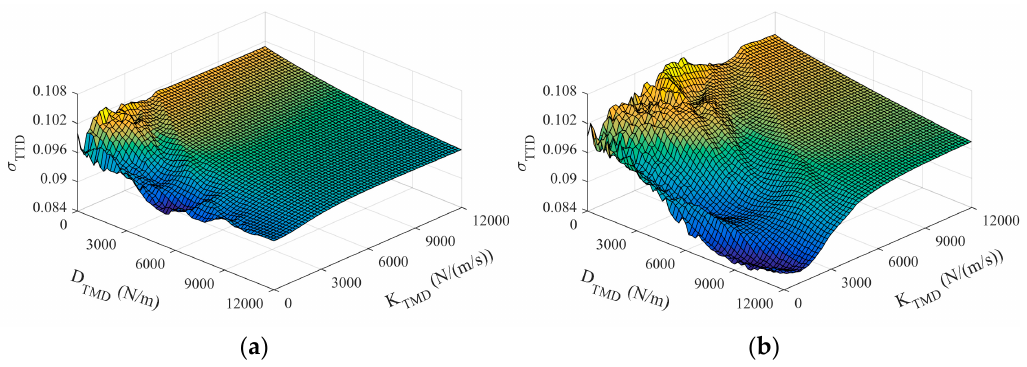
σ for different TMD mass ( a ) 10,000 kg; ( b ) 20,000 kg. Figure 6. 3D Surface of TTD Figure 6. 3D Surface of σ TTD for different TMD mass ( a ) 10,000 kg; ( b ) 20,000